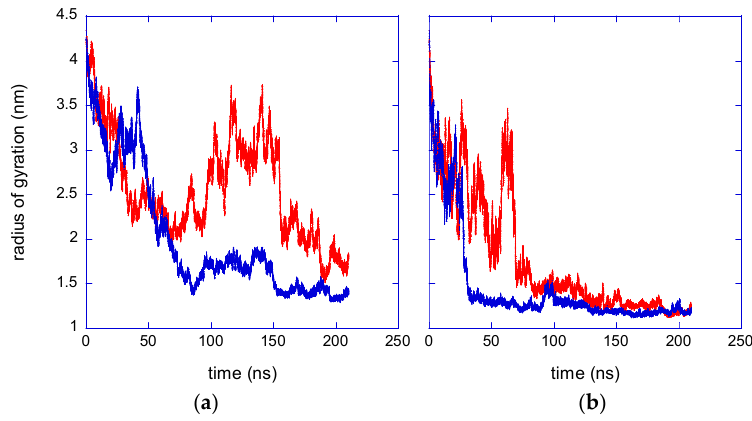
Figure 3. Time behaviour of the radius of gyration of the two-chain ensemble. Red and blue curves refer to atactic and isotactic-rich PNIPAM, respectively. ( a ) T = 283 K; ( b ) T = 323 K.